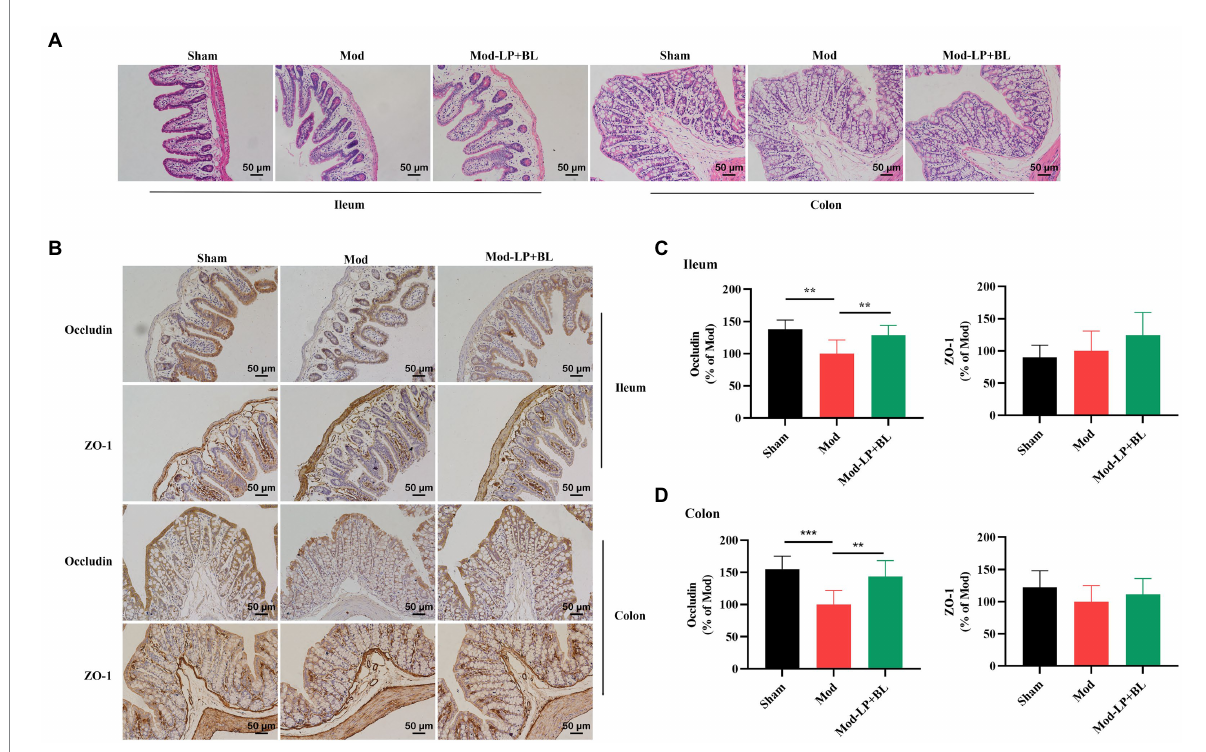
FIGURE 3 B. lactis and L. plantarum repair intestinal barrier damage in glioma mice. Representative (A) H&E, (B) ZO-1 and Occludin stained sections of ileum and colon tissues harvested from mice, scale bars, 50 μ m. Quantification of ZO-1 and Occludin immunopositive area in (C) ileum and (D) colon tissues, two-way ANOVA . Mod, Model. LP, Lactobacillus plantarum ; BL, Bifidobacterium lactis . * p < 0.05, ** p < 0.01, *** p < 0.001. n =